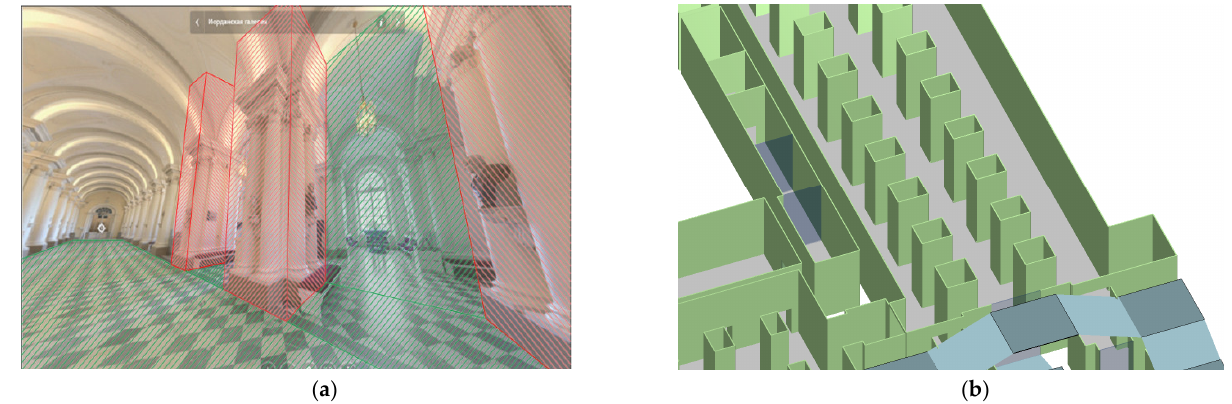
Figure 5. C olumns in the Jordan Gallery ( a ); Columns in the Jordan Gallery in the model ( b ). As a second simplification, window niches are excluded from the calculation area (they do not lie on the evacuation routes). The exclusion of window niches from the com- putational domain entails a reduction of the computational domain for simulating fire development (Figure 6).